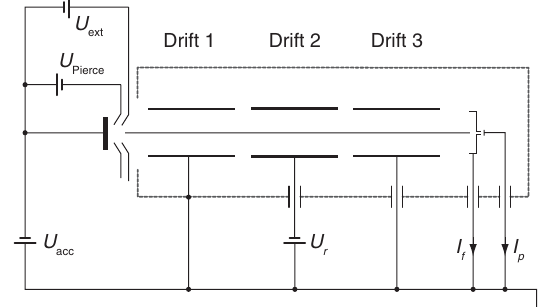
FIG. 1. Schematic of the TSR electron target in beam decel- eration mode. U : acceleration voltage; U : voltage at the acc Pierce Pierce electrode; U : extraction voltage; U : retarding voltage in r ext the deceleration region tube; I : full transmitted current; I : f p fraction of the current cut by a pinhole in the collector used to measure electron beam